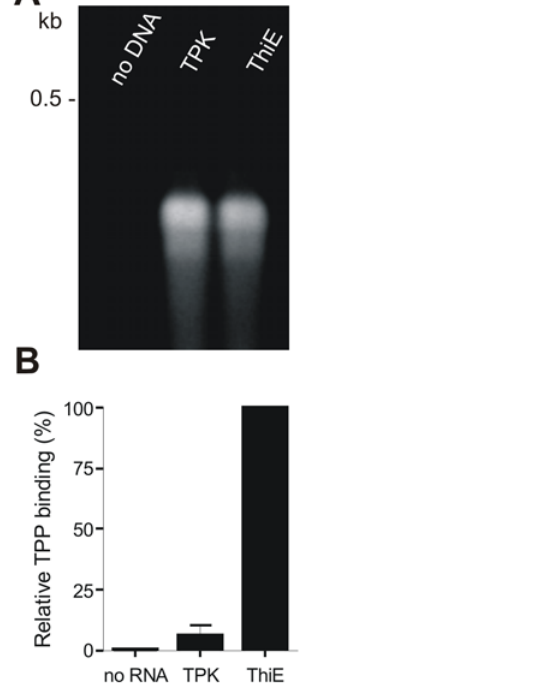
Figure 6. Analysis of TPP binding to its proposed THI boxes. (A) In vitro transcription of the potential 5 9 UTR 2 225 to 2 21 (relative to the translation start-site) of the operons consisting of gtpase , epi and tpk (TPK) and tenA , thiM , thiD and thiE (ThiE) using the MEGAscript in vitro transcription kit (Ambion, USA). As control the in vitro transcription was performed without DNA template (no DNA). (B) Relative binding affinity of TPP to the in vitro transcripted RNAs. The respective RNAs were denaturated, refolded and incubated with TPP [38]. Subsequently unbound TPP was separated from bound TPP by filtration and the TPP was oxidised to thiochrome. The fluorescence of thiochrome was detected at an excitation wavelength of 365 nm and at an emission wavelength of 455 nm. Data shown are from at least three independent experiments and expressed as percentage of the 5 9 UTR RNA of the tenA , thiM , thiD and thiE operon. No RNA, without RNA (control); TPK, 5 9 UTR sequence of the gtpase - epi - tpk operon; ThiE, 5 9 UTR sequence of the tenA - thiM - thiD - thiE